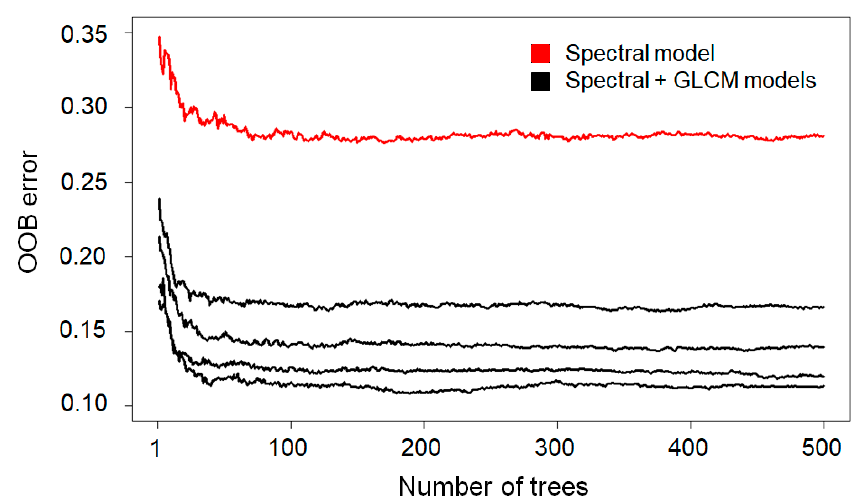
Figure 4. Random Forest models training history. The plot shows the evolution of the out-of-bag error as the number of trees increases. All models converge before training 100 decision trees.